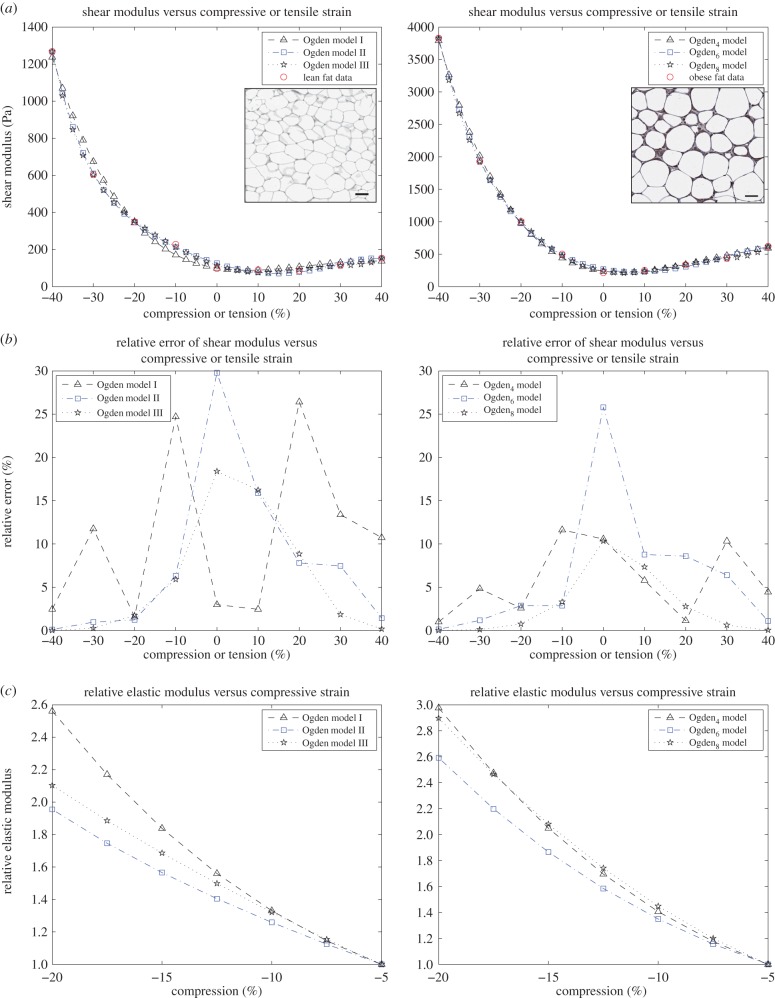
Fat data and models fit. Left: lean fat tissue. Right: obese fat tissue. (a) Shear modulus μ for Ogden4, Ogden6, Ogden8 models compared with experimental data for fat tissue at 3.5% shear superposed on up to 40% compression or tension; (b) the associated relative errors and (c) the elastic modulus E normalized to its value at 5% compression.